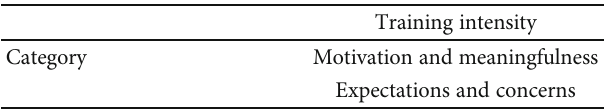
Table 5: Overview of